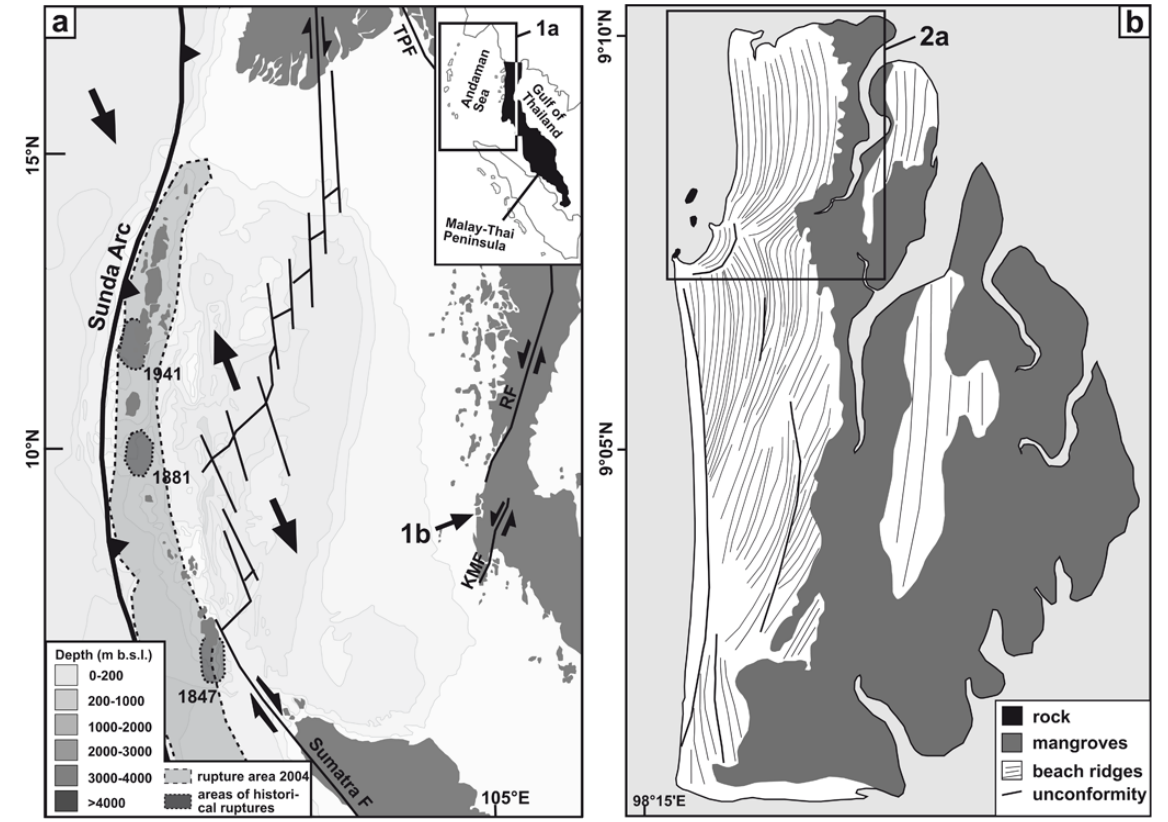
Fig. 1. Geographical and tectonic setting of the study area. (a) Tectonic structures of the Andaman Sea region (after Watkinson et al., 2008; KMF = Klong Marui Fault, RF = Ranong Fault, TPF = Three Pagodas Fault) with rupture areas of the 2004 megathrust (Subarya et al., 2006) and historical earthquakes (Bilham et al., 2005; Ortiz and Bilham, 2003) along the Andaman-Nicobar segment of the Sunda Arc. (b) Overview of Ko Phra